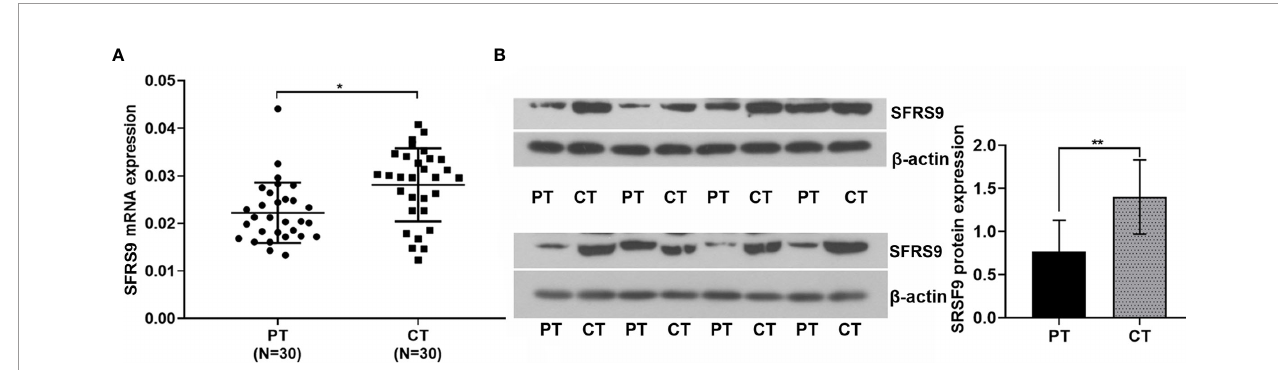
FIGURE 1 | Expression of SFRS9 mRNA and protein in colon cancer tissues and paracancerous tissues. (A) Expression of SFRS9 mRNA level in different tissues (CT, CRC tissues; PT paracancerous tissues, N=30). (B) Expression of SFRS9 protein level in different tissues; N, 8). Values are mean ± SD. *p < 0.05, **p <